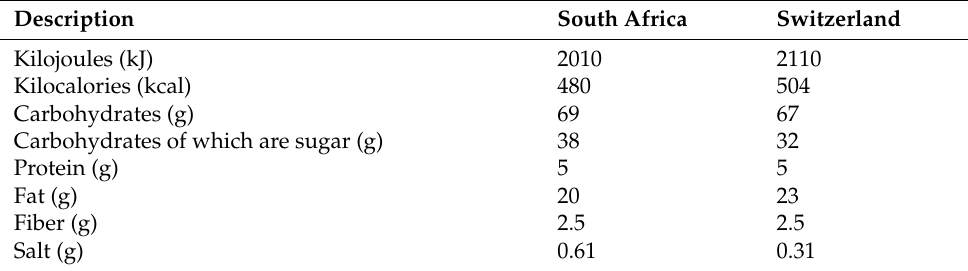
Table A1. Nutritional value of chocolate-based biscuits per 100g.